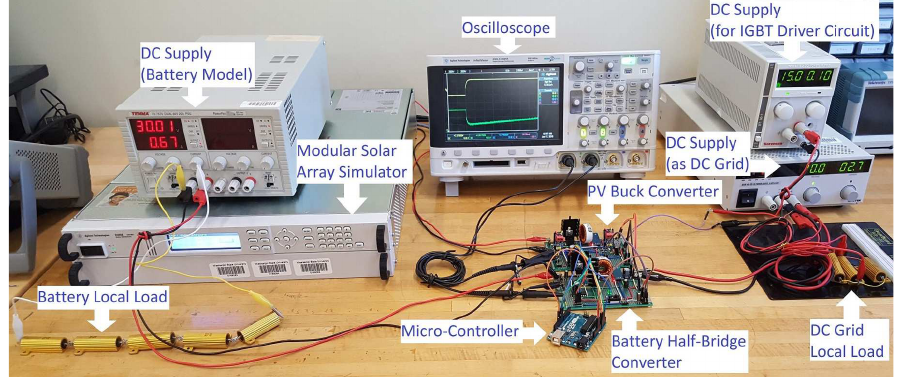
Figure 21. Experimental setup. Table 6. Experimental setup